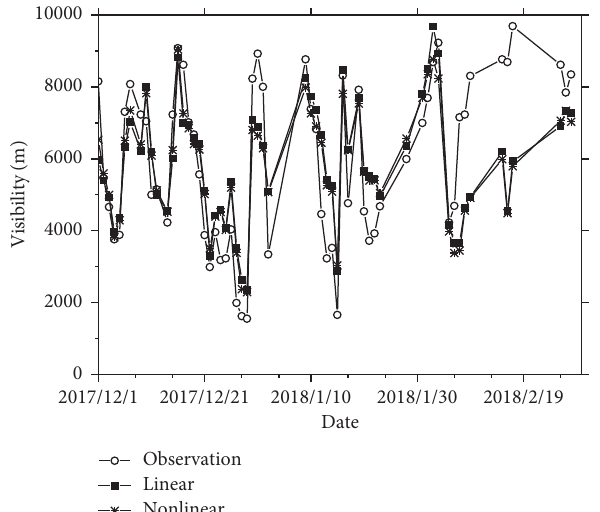
Figure 8: Time series of daily observed visibility and simulated visibility by linear and nonlinear regression equations.